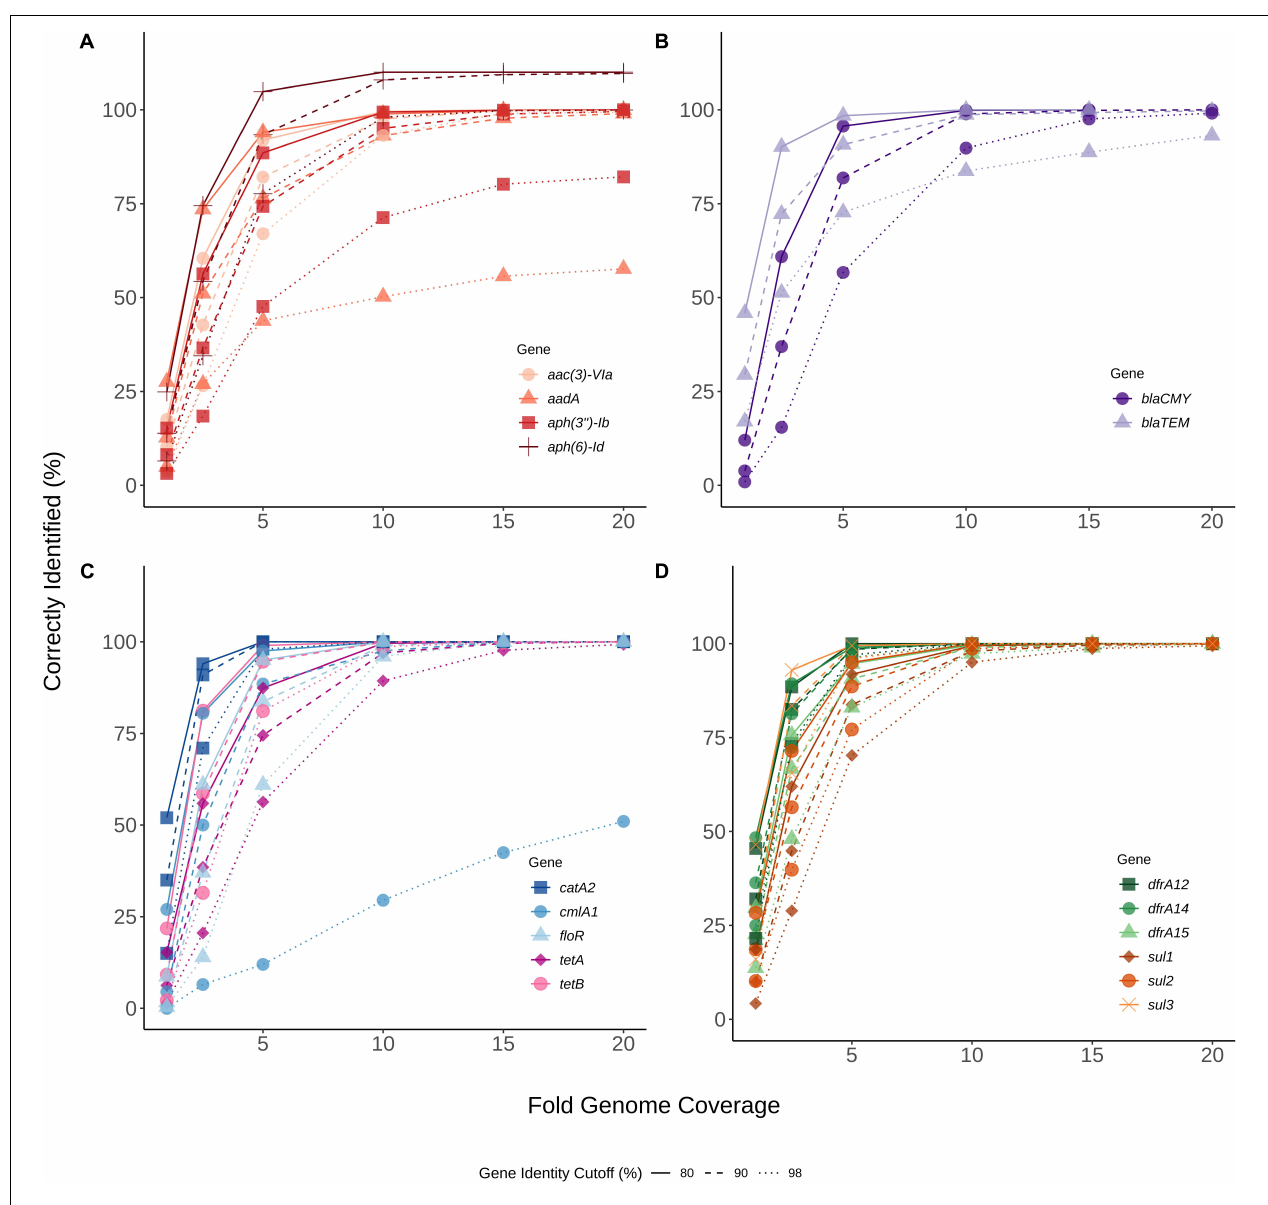
FIGURE 1 | Genome coverage required to detect antibiotic resistance genes (ARGs). Various levels of sequence coverage (1X, 2.5X, 5X, 10X, 15X, 20X) were subsampled 100 times from raw-reads of sequence files for each of 111 Salmonella isolates. (A) Aminoglycoside resistance genes, (B) Beta-lactamase resistance genes, (C) Phenicol, florfenicol, and tetracycline resistance genes, (D) Trimethoprim and sulphonamide resistance genes. Each of the subsampled sequences was analyzed for ARGs using KMA v 1.17 and the ResFinder database. Percent correctly identified at 80% (continuous line), 90% (dashed line) and 98% (dotted line) gene identity was determined by dividing the total number of hits by the expected number of hits. The x -axis represents the sampled fold genome coverage. Genes are differentiated by color and shape